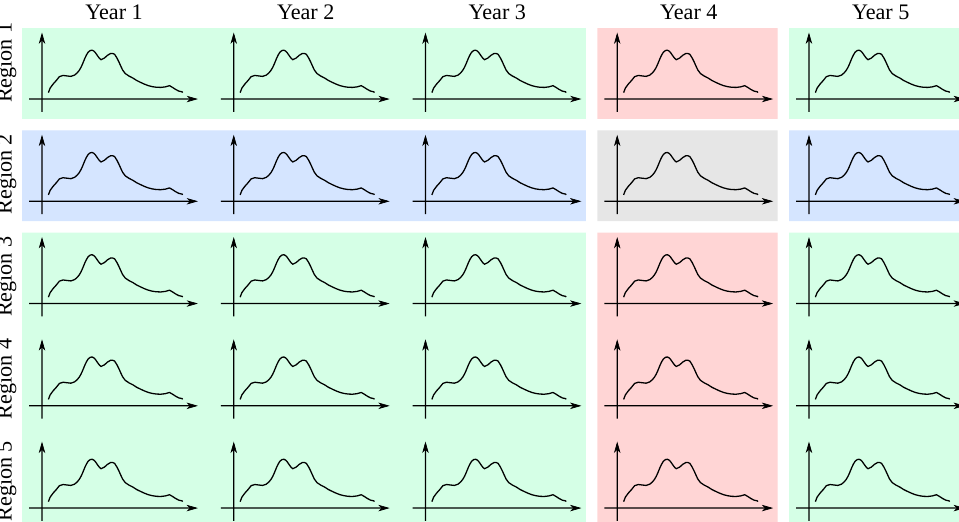
Figure 2. Illustration of different data pools for EDM. In grey, the example we want to forecast, is the testing series. In blue, is the method we call classic, which uses as library of patterns all the examples of the same region. In pink, is the method annual, which uses as library all the examples from the same year. In green, is the method pool, where we use the biggest library, taking all the series that are not from the same region or the same